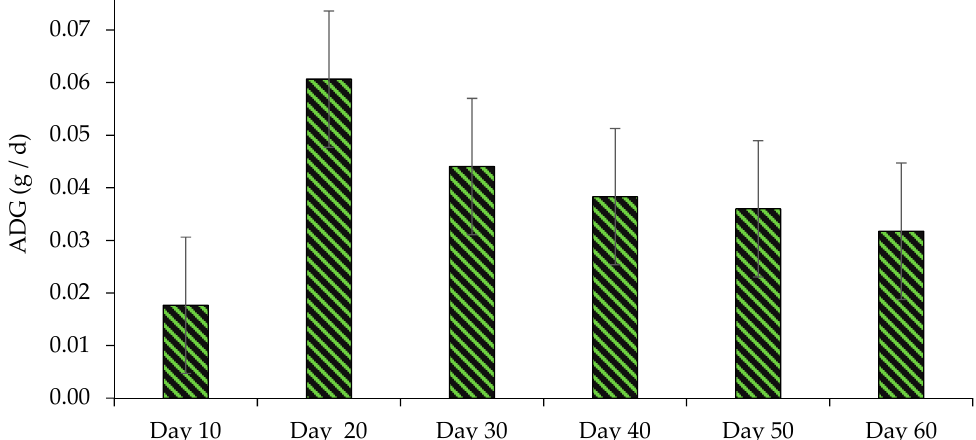
Figure 4. Average daily weight gain (ADG) of Poecilia latipinna . The weight of fish samples was